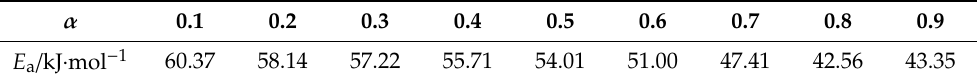
Table 1. The apparent activation energy values at di ff erent conversion degrees obtained by the Friedman method.